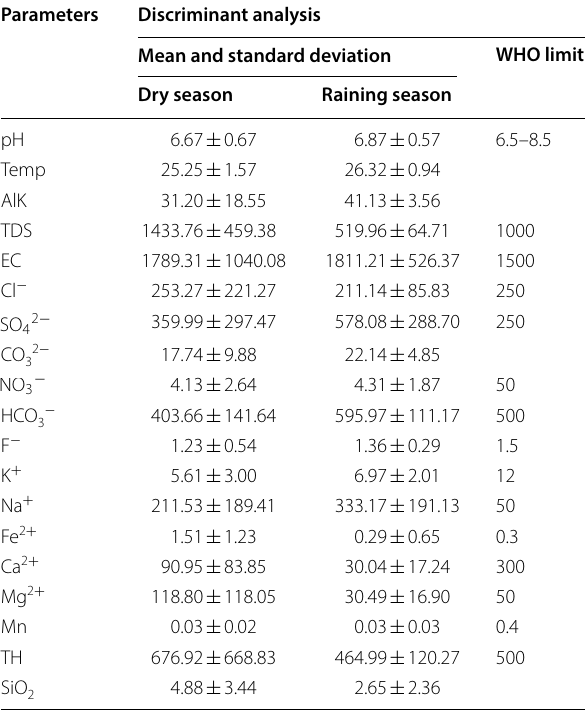
Table 6 Statistical characteristics of discriminant